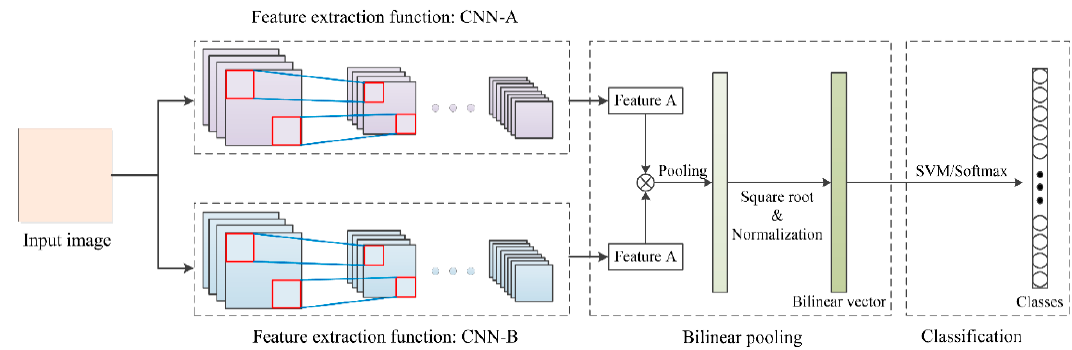
Figure 7. Pipeline of the bilinear-CNN model proposed by Lin et al. [63].